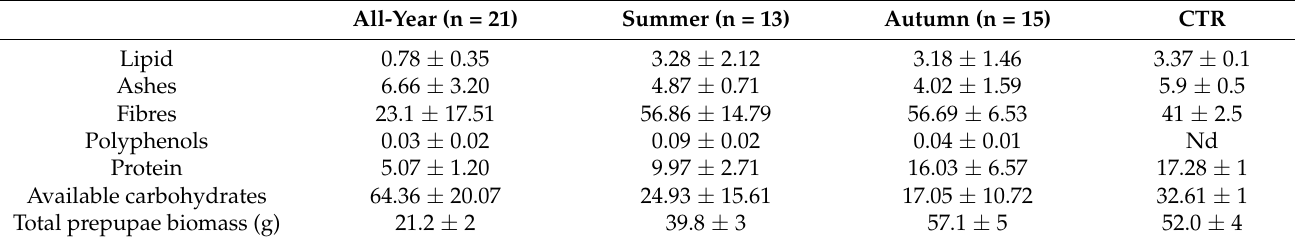
Table 1. Mean percentage composition of the different diets, expressed as g/100 g dry matter and corresponding amount of total prepupal biomasses obtained (g) starting from 300 Black Soldier Fly (BSF) larvae. Nd = not